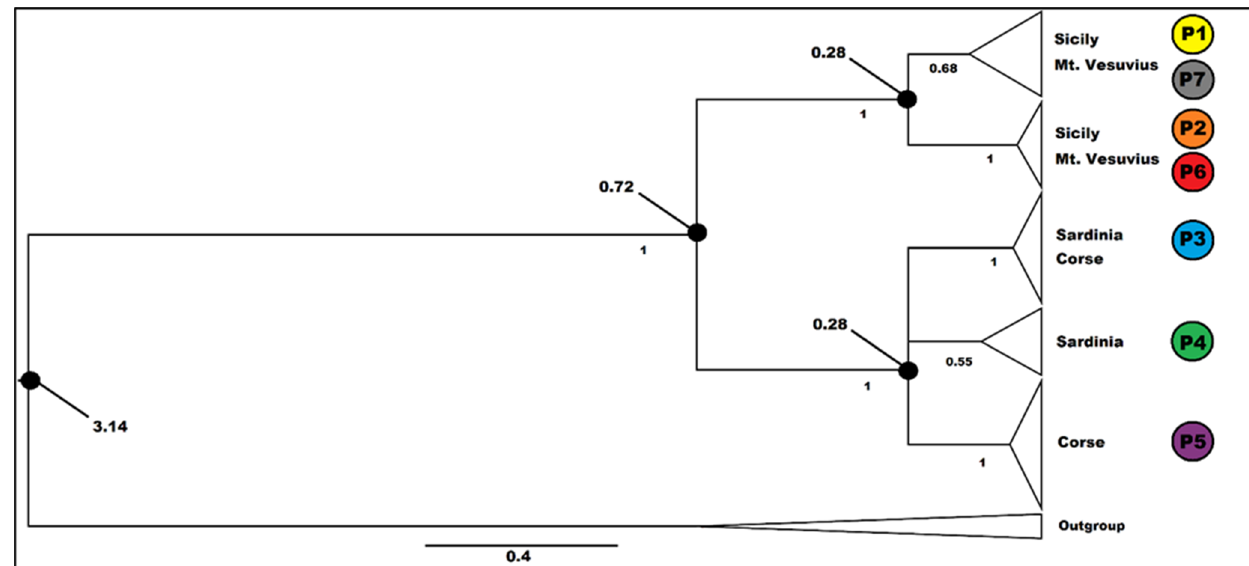
Figure 3. Calibrated Bayesian analysis on the plastid sequences of the inclusive group in the study of Genista etnensis populations (outgroup = G. fasselata ). Posterior probabilities are indicated below the branches (PP > 0.5 are shown); relevant dates (Ma) on the nodes (black circle). Triangles are proportional to the number of individuals. For haplotype distribution and information, see Figure 1.